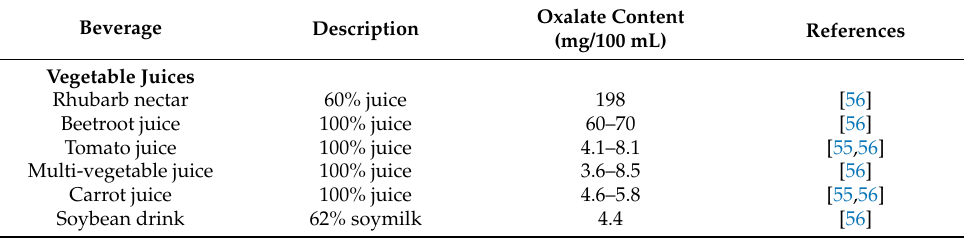
Table 2. Oxalate content of